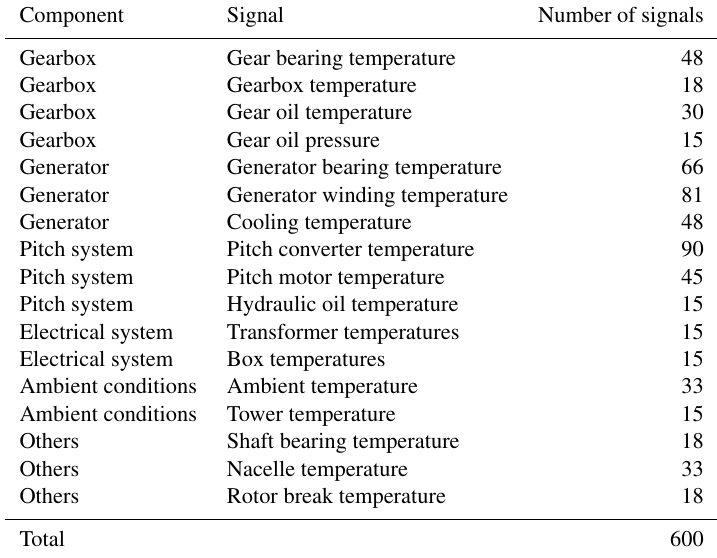
Table B1. Full list of analysed